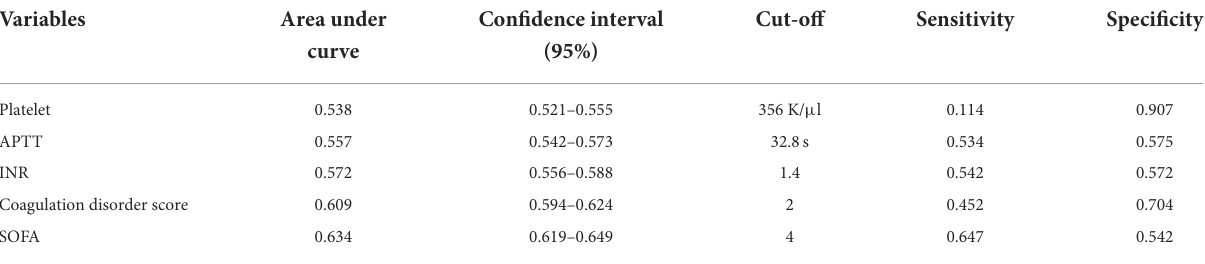
TABLE 6 Performance evaluation of coagulation disorder score and single indicators in predicting the 90-day all-cause mortality. Variables Area under Confidence interval Cut-off Sensitivity Specificity